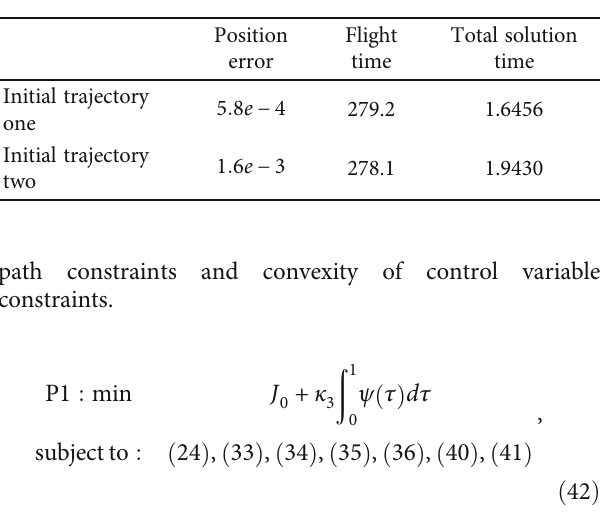
Figure 12: Comparison of control variables. Table 5: Comparison of the results of di ff erent initial